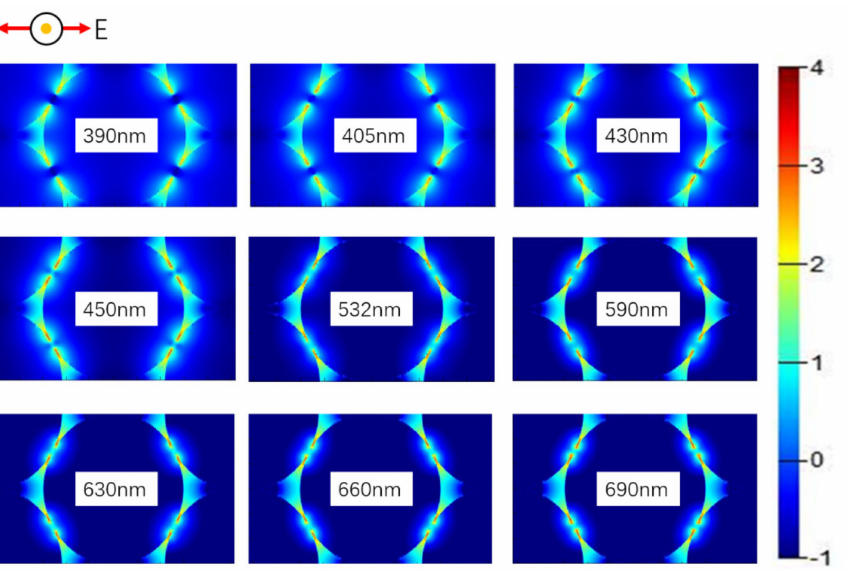
Figure 7. Electric field distribution of Ag NPs stacked by SL-HCP. The color bar on the far right represents an order of magnitude of E 2 . The red arrow in the upper left corner is the direction of the electric field vibration of the plane wave, and the black circle of the yellow dot is the direction of the energy flow.